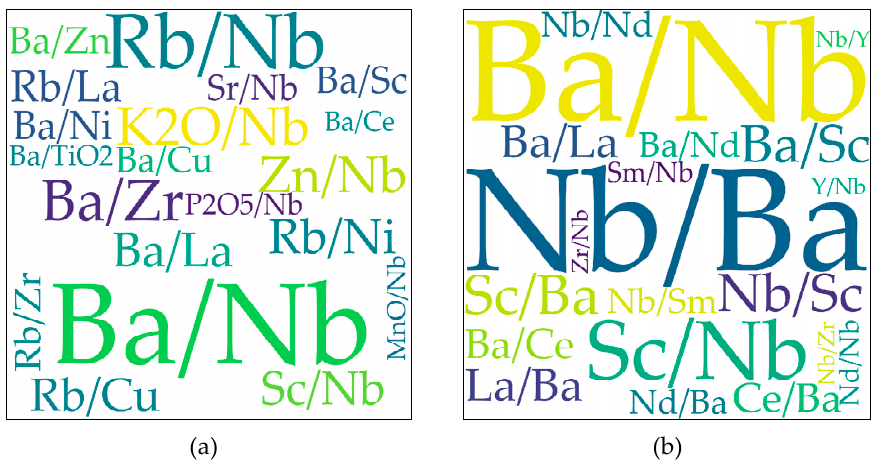
Figure 12. Word clouds of the top 20 important elements (or element ratios) for IAG and non-IAG discrimination diagrams. ( a ) is for linear coordinates; ( b ) is for logarithmic coordinates.